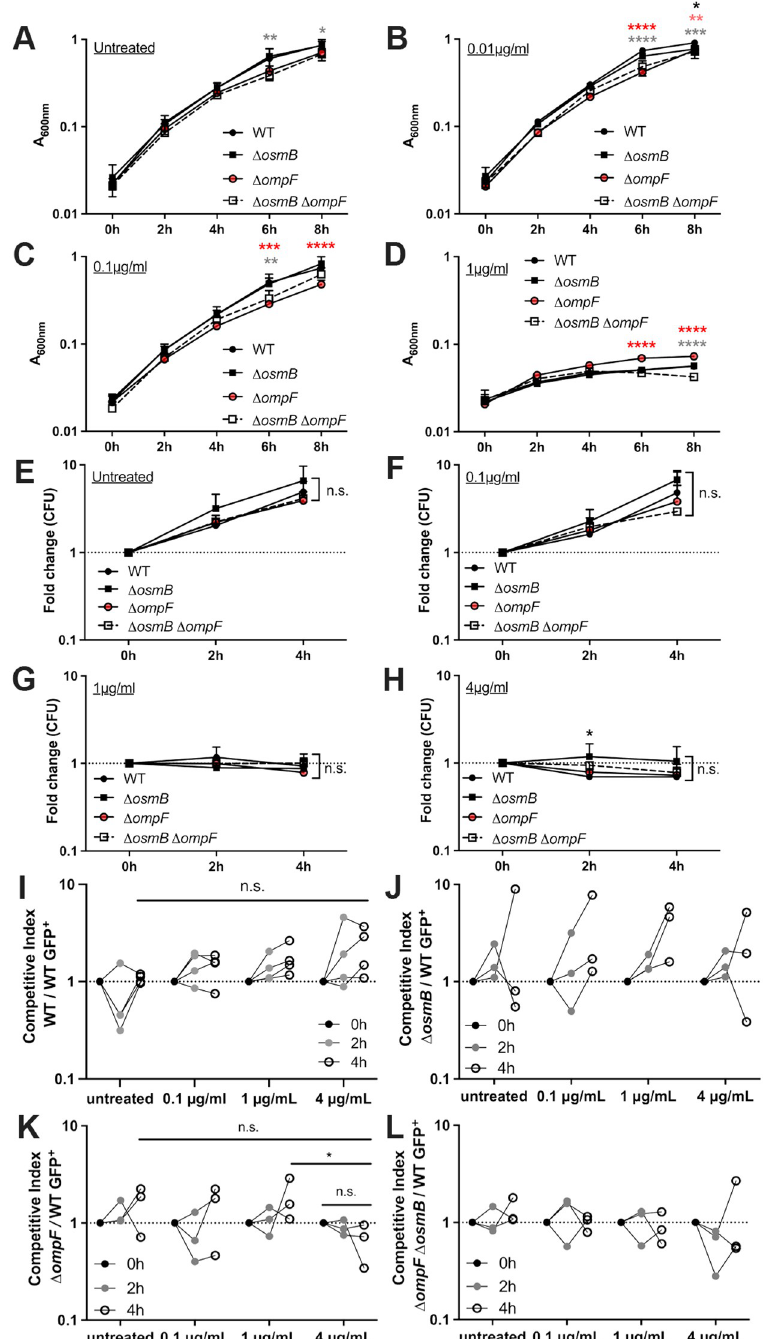
Fig 3. ompF mutants have slightly impaired growth in the presence of doxycycline. Exponential phase cultures of the WT and mutant strains ( Δ osmB , Δ ompF , Δ osmB Δ ompF ) were treated with the indicated concentrations of Dox to assess (A-D) growth inhibition, (E-H) changes in viable counts, and (I-L) competitive survival. (A-D) Strains were incubated with the indicated concentrations of Dox and growth inhibition was assessed based on absorbance (A 600nm ) at the indicated timepoints (time: hours, h). Data represents the mean and standard deviation of three biological replicates. (E-H) Strains were incubated with the indicated concentrations of Dox and viable counts were determined by quantifying CFUs. Fold change in CFUs is shown relative to time 0h. Dotted line: a value of 1, no change relative to 0h. Data represents the mean and standard deviation of three biological replicates. (I-L) Competitive survival in the presence of the indicated concentrations of Dox; WT, single and double mutants were tested alongside the WT GFP + strain. Competitive index (CI): CFUs of the test strain/WT GFP + divided by the ratio of test strain /WT GFP + in